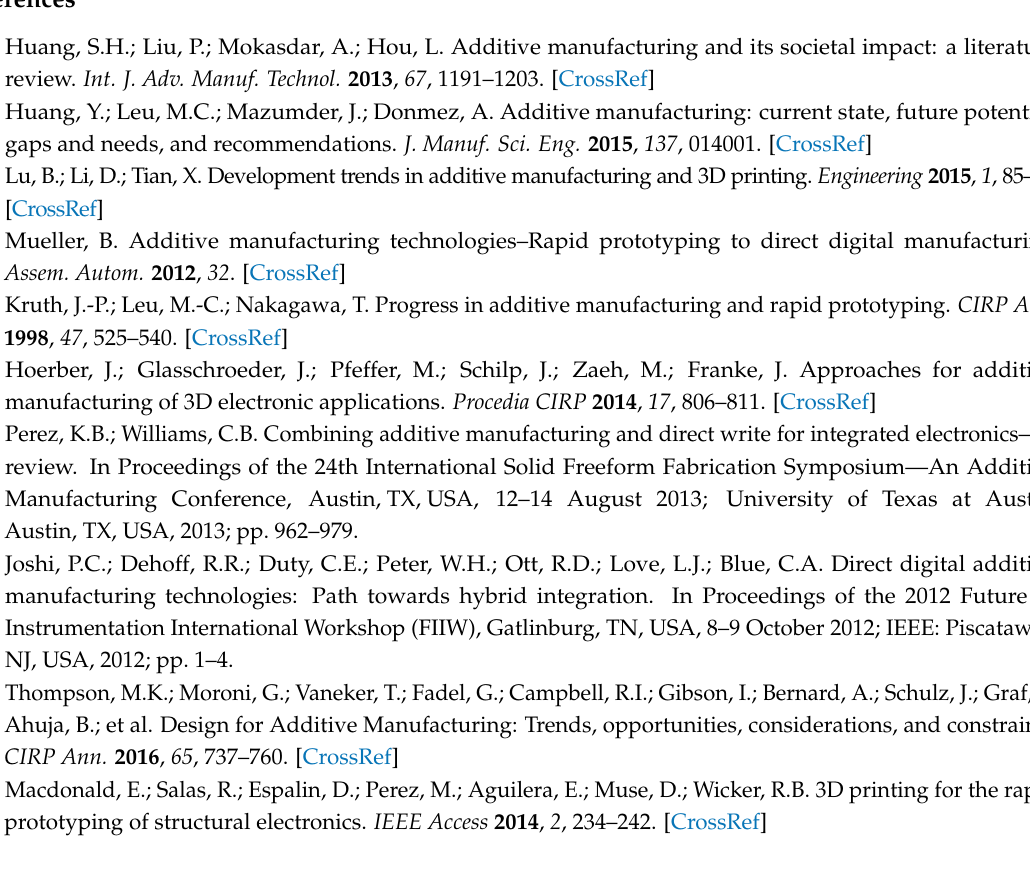
Figure S1: Processing onto PVA substrate using Inkjet printing and conventional photolithography; Video S1: Video showing tattoo electronics process; Video S2: Video Showing Water Transfer Printing